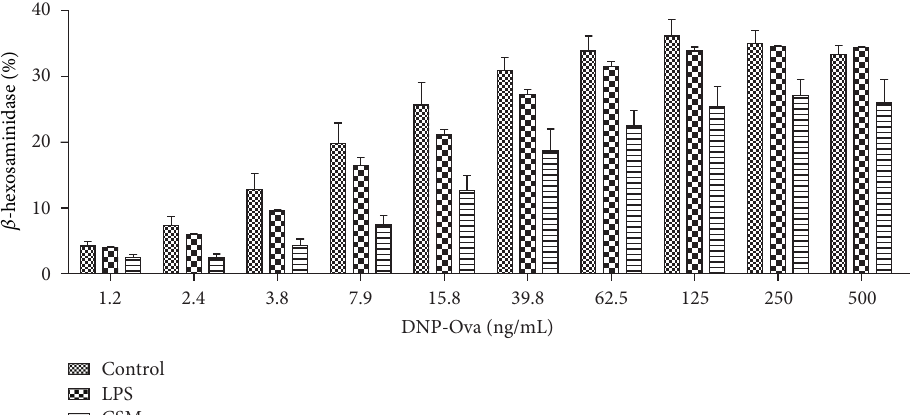
Figure 3: Long-term exposure of mast cells to CSM inhibits allergic degranulation. BMMCs were cultured in regular culture medium, in the presence of CSM (1.5%) or LPS (100ng/mL) in the third week of bone marrow culture. Then, cells were sensitized with DNP-specific IgE, followed by activation with dinitrophenyl-conjugated human ovalbumin (DNP-Ova). Degranulation was assessed by the release of 𝛽 - hexosaminidase in the supernatants from cells. Data are mean ± SEM of quadruplicate samples ( 𝑛 = 4